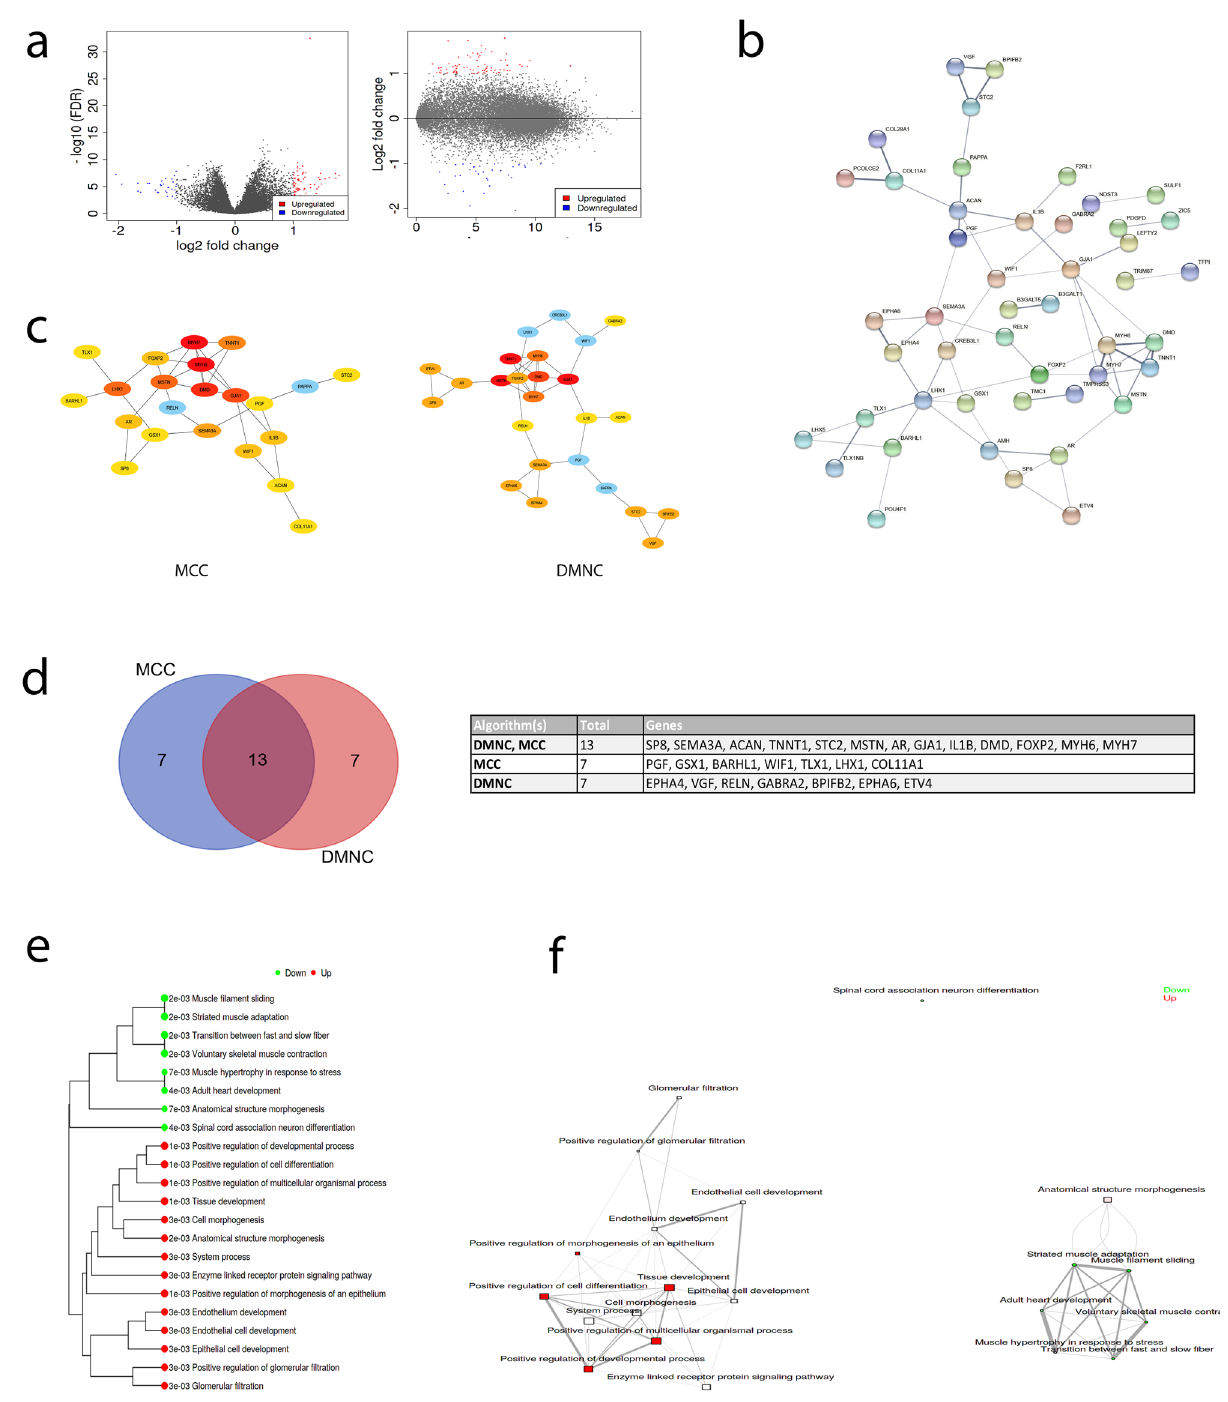
Figure 4. Exploratory analysis of the DEGs in LGG cases with high versus low DMD expression. ( a ) Volcano and M-A plots of the log fold change of all genes. Upregulated and downregulated genes are indicated by red and blue points respectively. ( b ) STRING PPI network of DEGs with 60 edges (versus 20 expected) and an enrichment P value of 7.92e−13. Edge thickness indicates confidence, disconnected nodes are hidden. ( c ) Identification of significant hub genes from DEGs using the Cytohubba MCC and DMNC algorithms within Cytoscape. Colour represents ranking based on corrected P values from red to yellow, the expanded subnetwork is displayed by blue nodes. ( d ) Venn analysis of both sets of hub genes reveals 13 common significant hub genes. ( e ) Network tree visualisation of the enriched pathways in DEGs using the GO biological processes annotation, dot size corresponds to adjusted P values. ( f ) Visualisation of the relationship among enriched GO categories. Connected gene sets share more genes, colour of node represents adjusted P